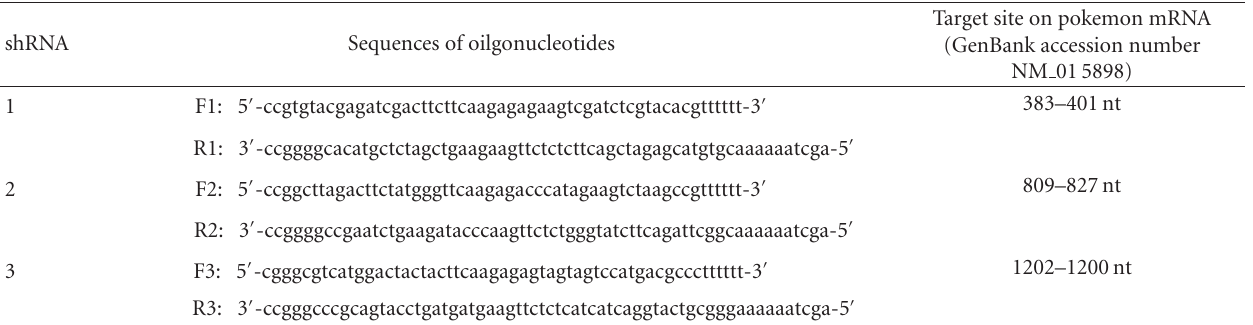
Table 1: Sequences of oilgonucleotides used in the research.